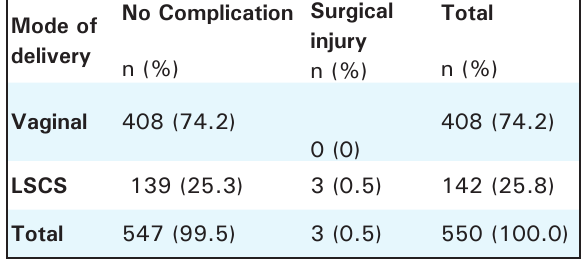
Table 5. Association between mode of delivery and surgical injury.